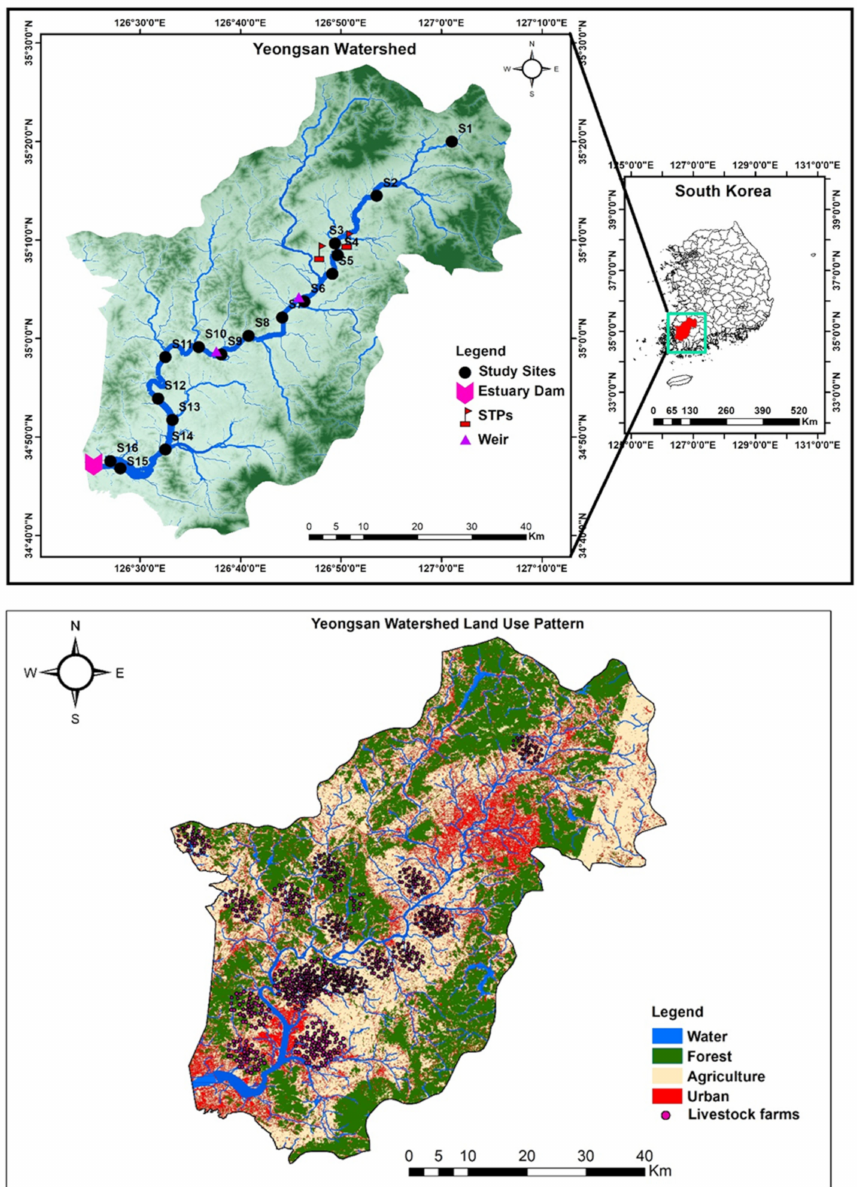
Figure 1. Maps showing water quality monitoring sites, land use patterns, livestock farms, and other facilities in the Yeongsan River basin in South Korea (STPs: sewage treatment